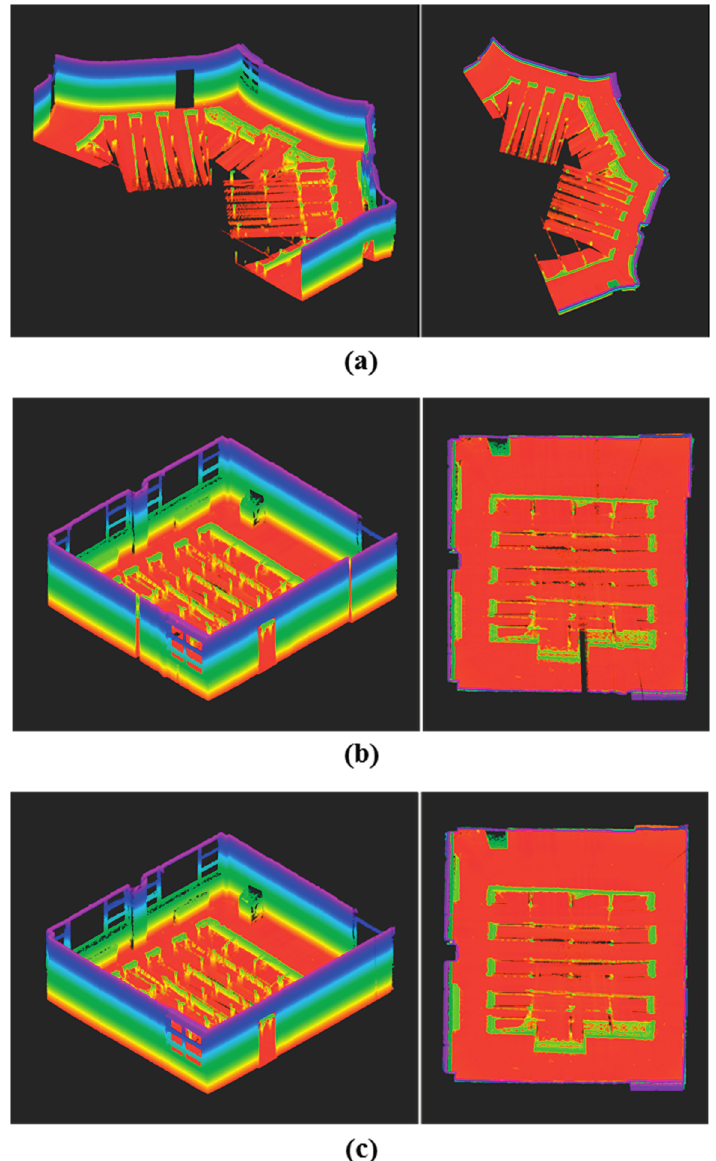
Figure 13. Point-cloud data acquisitions of the seminar room by kinematic scanning: ( a ) odometry only; UKF SLAM ( b ) without and ( c ) with the constraint